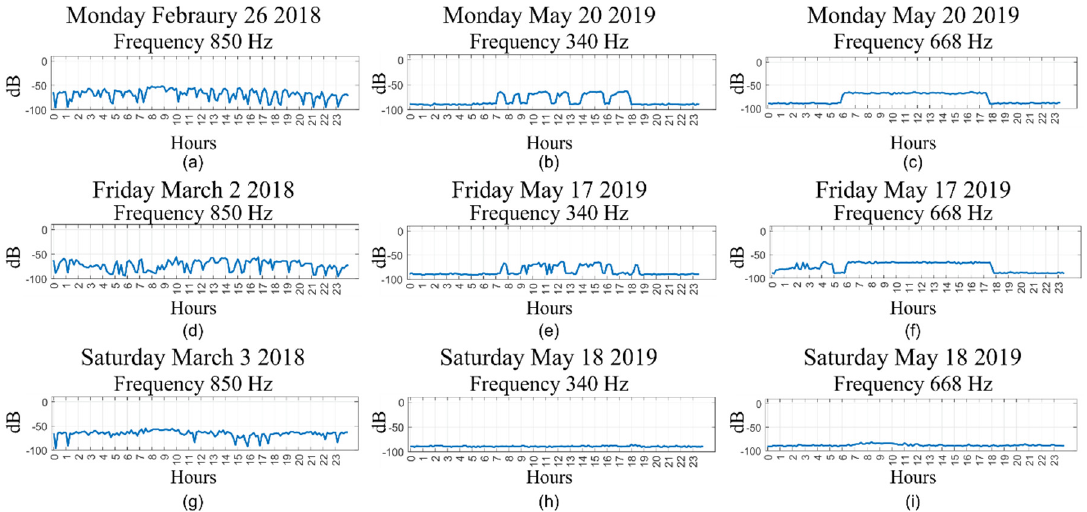
Figure 8. SFC for the current signals: ( a ) frequency 850 Hz Monday 26 February 2018, ( b ) frequency